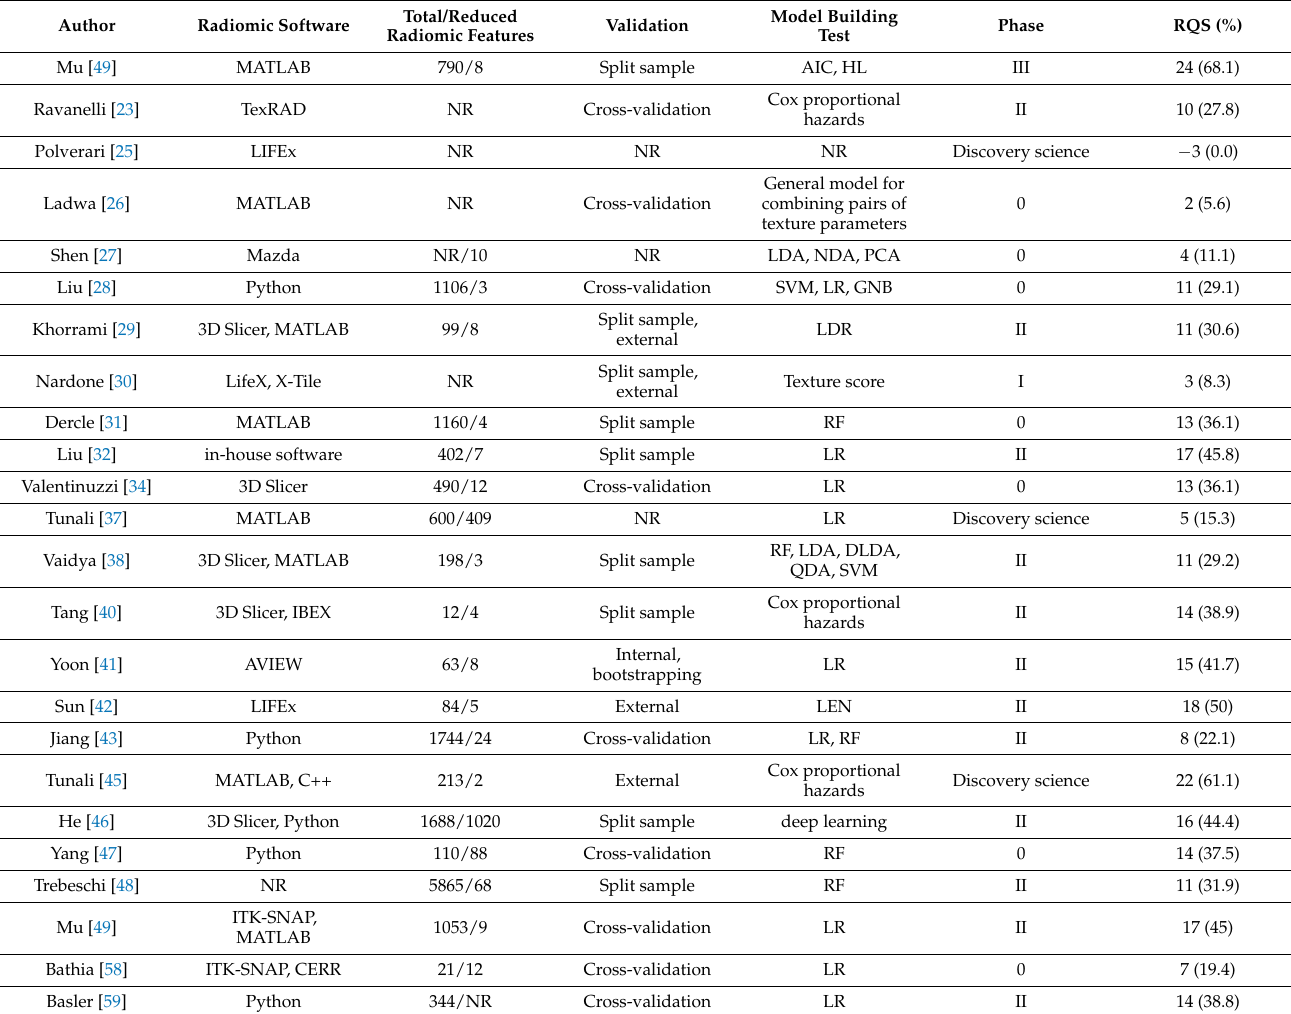
Table 2. Summary of radiomic